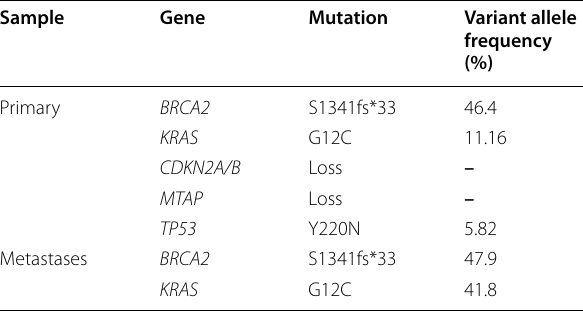
Table 1 Mutated genes in primary tumor and brain metastases of pancreatic cancer